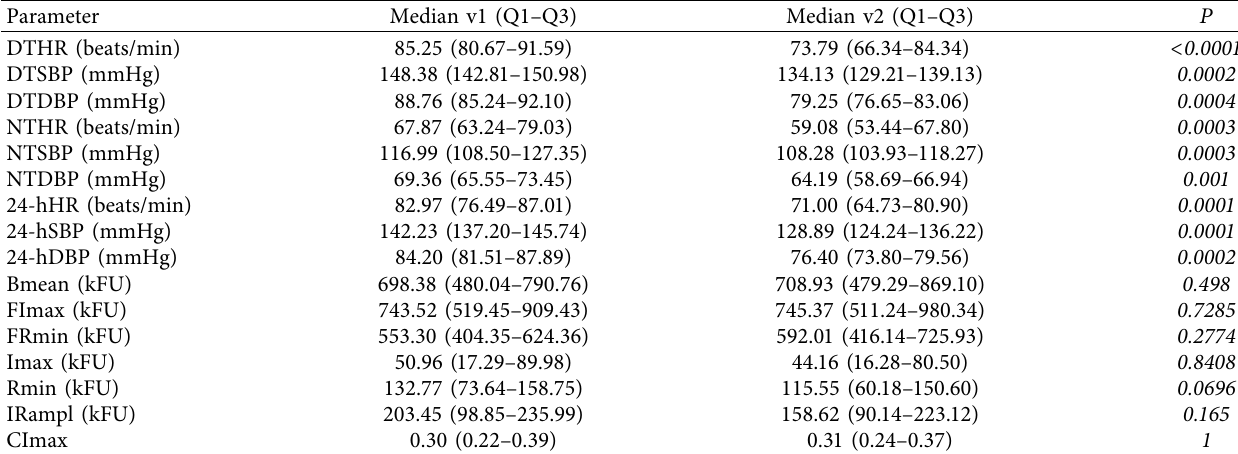
Table 4: Summary of continuous measures for hypertensive patients assigned to nebivolol at 5 mg QD. P values of the paired analysis of continuous data with a nonparametric Wilcoxon test for comparison of results before and after the six-week treatment. Parameter